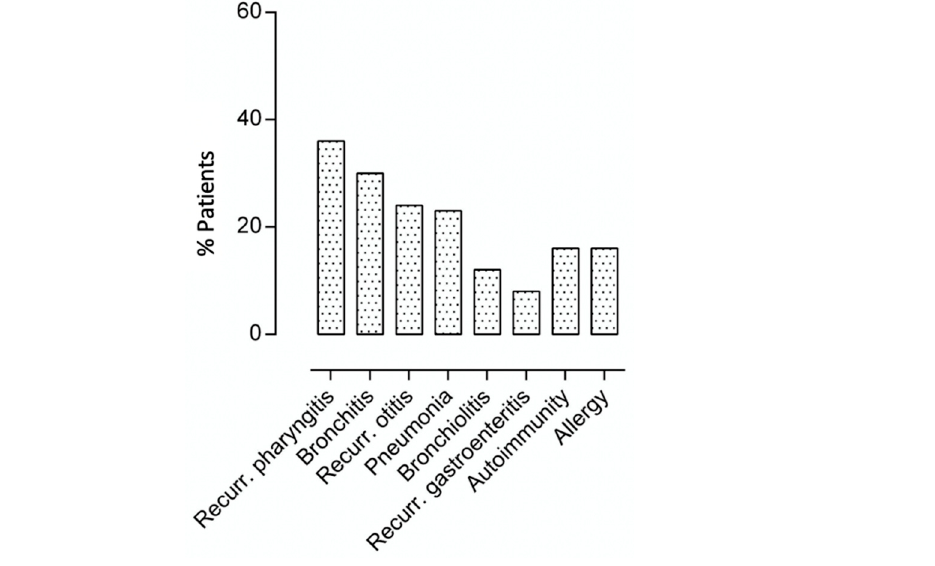
Figure 1. Prevalence of clinical manifestations at SIgAD diagnosis. Table 2. Incidence of infectious manifestations in 67 patients with SIgAD during follow-up.